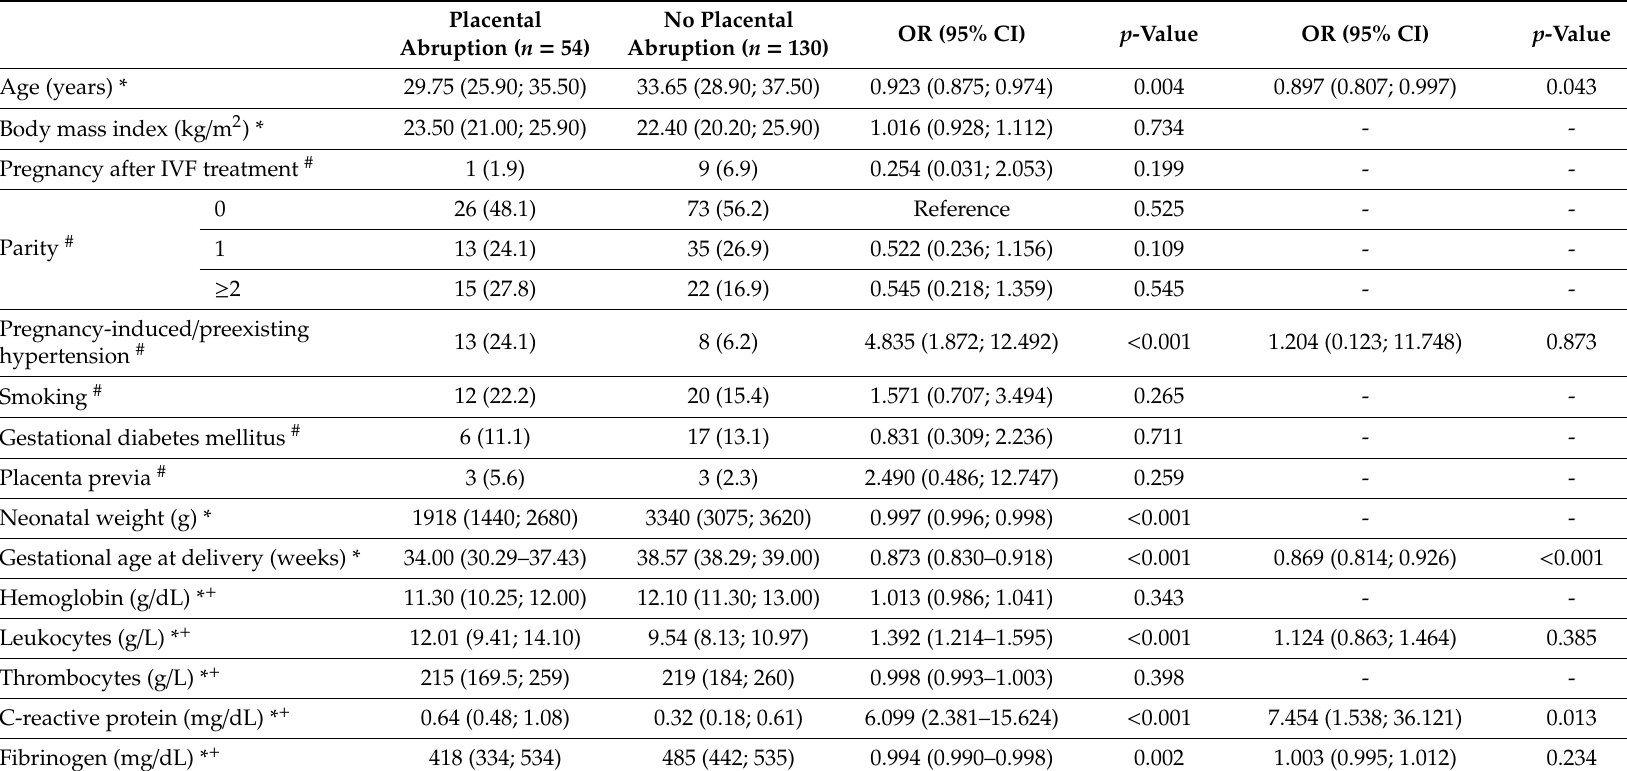
Table 3. Non-bleeding women with and without placental abruption: comparison of basic patient characteristics and laboratory parameters within 48 h before Caesarean